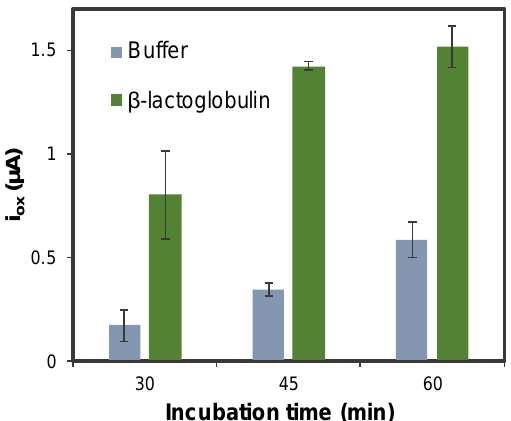
Figure 5. Optimization of the incubation time (aptamer-target interaction) in the AuNPs@PLL-GSPE. Experimental conditions: [ β -LG] = 0 and 5.0 ng·mL −1 , [Apt-MB] = 1 µM, oxidation DPV recorded between − 0.60 V and +0.15 V, using the following conditions: modulation time: 0.02 s; interval time: 0.5 s; step potential 0.005 V; modulation amplitude 0.10 V. Solutions made in 0.1 M PBS, 150 mM NaCl pH = 7.4. Data are given as average ± SD (n = 3).